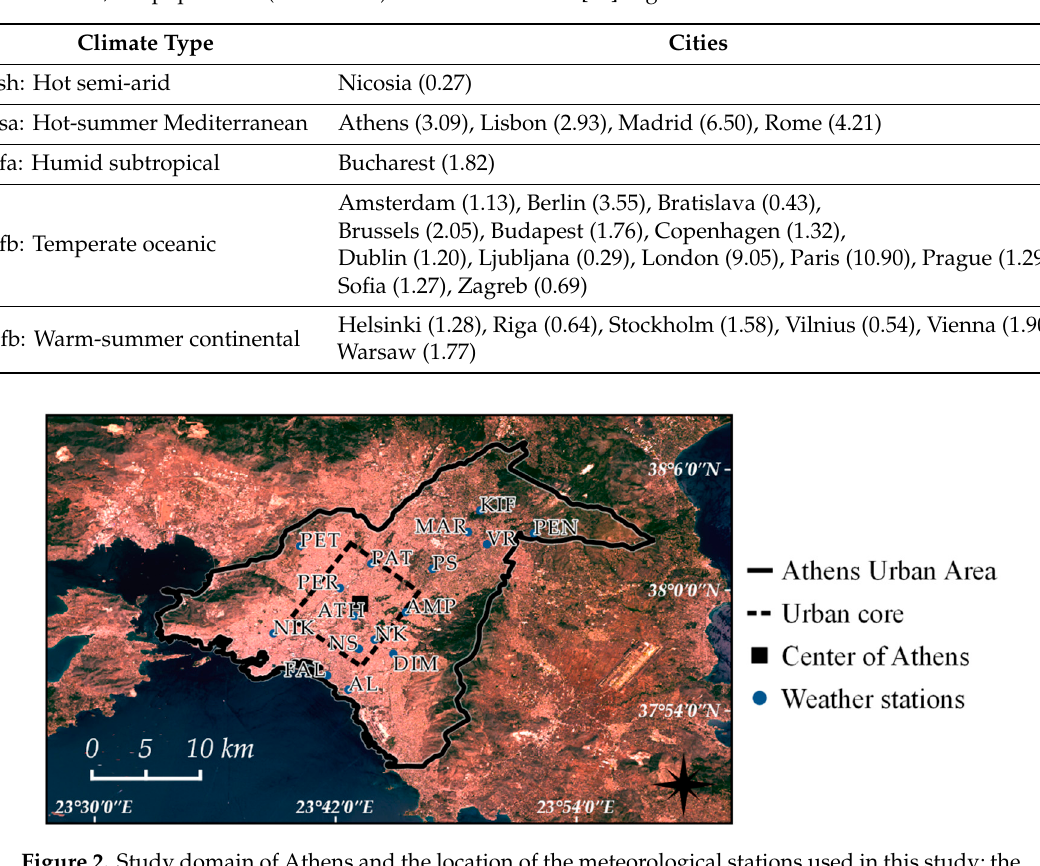
Table 1. Köppen-Geiger climate types for the European cities used in this study; source: [71]. In brackets, the population (in millions) of each urban area [77] is given.